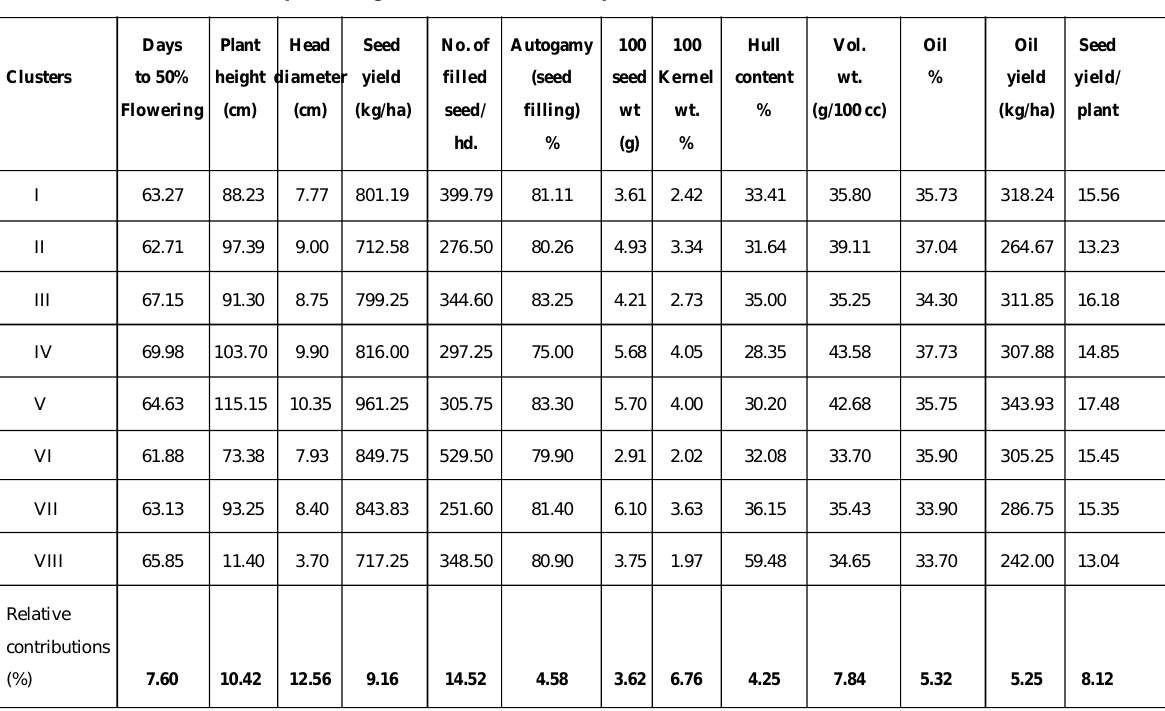
Table 8: Cluster mean and percentage contribution of 13 quantitative traits Days Plant Head Seed No. of Autogamy 100 100 Hull Vol. Oil Oil Seed Clusters to 50% height diameter yield filled (seed seed Kernel content wt. % yield yield/ Flowering (cm) (cm) (kg/ha) seed/ filling) wt wt. % (g/100 cc) (kg/ha) plant hd. % (g) %